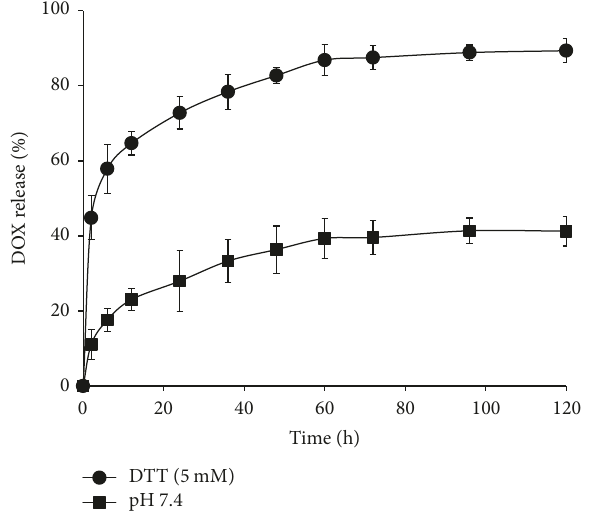
Figure 7: In vitro release profiles of DOX from PNS-SS-ADA@CD- mPEG in PBS (pH 7.4) with and without DTT (5mM).